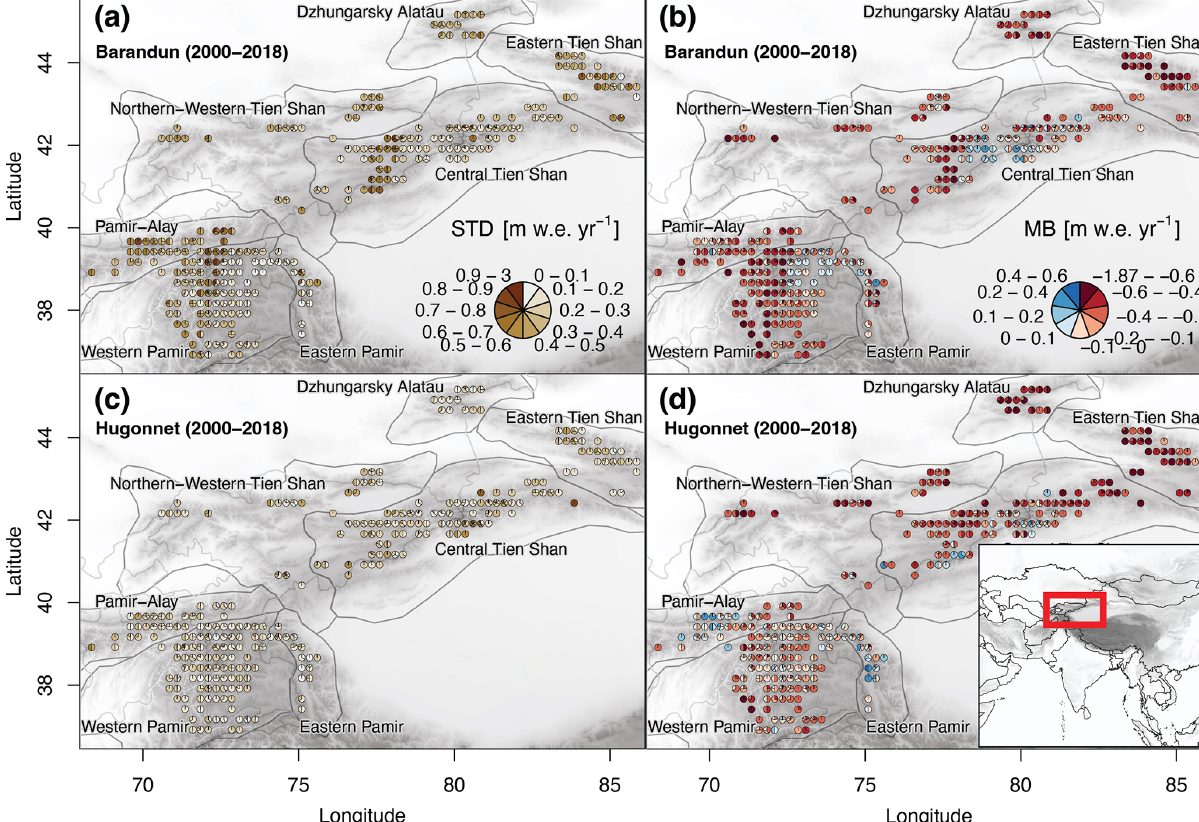
Figure 1. Overview map of the study region. (a, c) Glacier mass balance variability in terms of standard deviation (SD) and (b, d) average glacier mass balance (MB) estimates (a, b) from Barandun et al. (2021a) and (c, d) Hugonnet et al. (2021). Estimates from Hugonnet et al. (2021) include only the glaciers for which the transient-snowline-constrained modeling of Barandun et al. (2021a) provides estimates. The pie charts aggregate values per glacier into classes and the relative class frequencies. Pie charts are not scaled to glacier area. The seven subregions of the Hindu Kush Himalayan Monitoring and Assessment Programme (HIMAP) classification (Bolch et al., 2019) are shown in grey